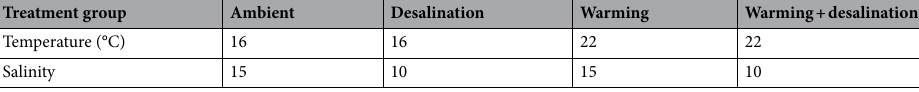
Table 4. Abiotic treatment groups used in the functional response